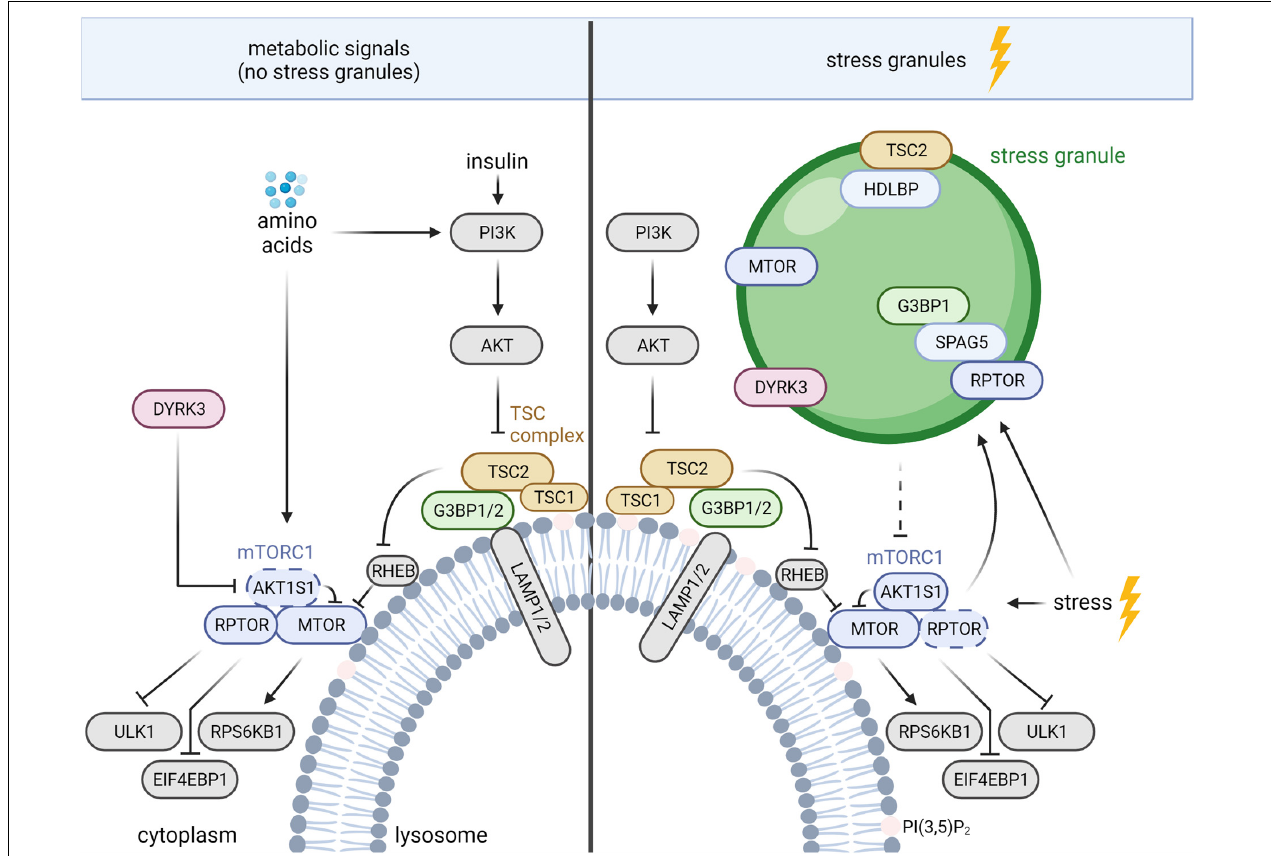
FIGURE 1 | TSC complex-mTORC1 signaling during nutrient sufficiency and stress granule (SG) formation. The mechanisms are described in the text. AKT, AKT serine/threonine kinase; AKT1S1, AKT substrate 1; DYRK, dual specificity tyrosine phosphorylation regulated kinase 3; EIF4EBP1, eukaryotic translation initiation factor 4E binding protein 1; G3BP 1/2, stress granule assembly factor 1/2; HDLBP, high density lipoprotein binding protein; LAMP1/2, lysosomal associated membrane proteins 1/2; MTOR, mechanistic target of rapamycin kinase; PI3K, phosphoinositide 3-kinases; PI(3,5)P 2 , phosphatidylinositol-3,5-bisphosphate; RHEB, RAS homolog-mTORC1 binding; RPS6KB1, ribosomal protein S6 kinase B1; RPTOR, regulatory associated protein of MTOR complex 1; SPAG5, sperm associated antigen 5; TSC1/2, TSC complex subunit 1/2; ULK1, unc-51 like autophagy activating kinase 1. Dashed arrow, inhibition via disassembly of